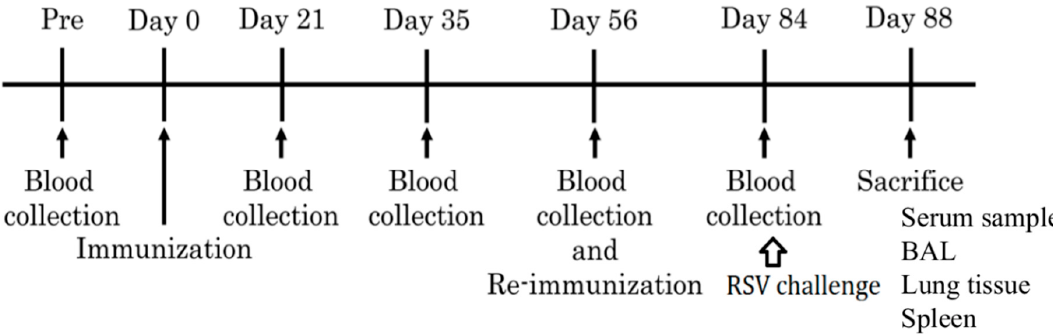
Figure 1. Schedule for immunization, the challenge test, and sample collection. Recombinant vaccines were administered on Days 0 and 56 and cotton rats were challenged with RSV on Day 84. They were sacrificed four days after the RSV challenge (Day 88).